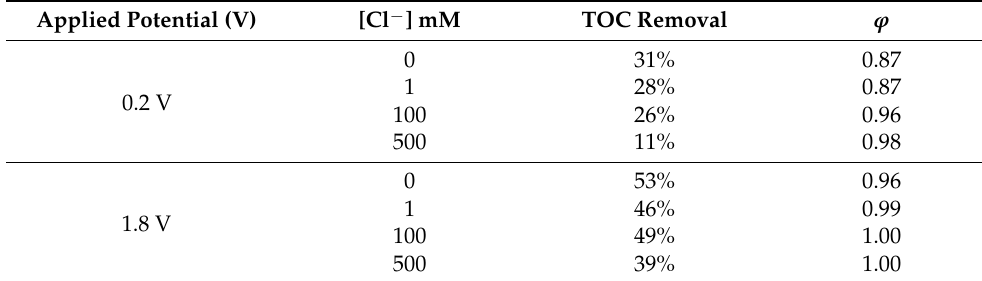
Table 1. TOC removal and ϕ evaluated at the end of each run. Applied Potential (V) [Cl − ]